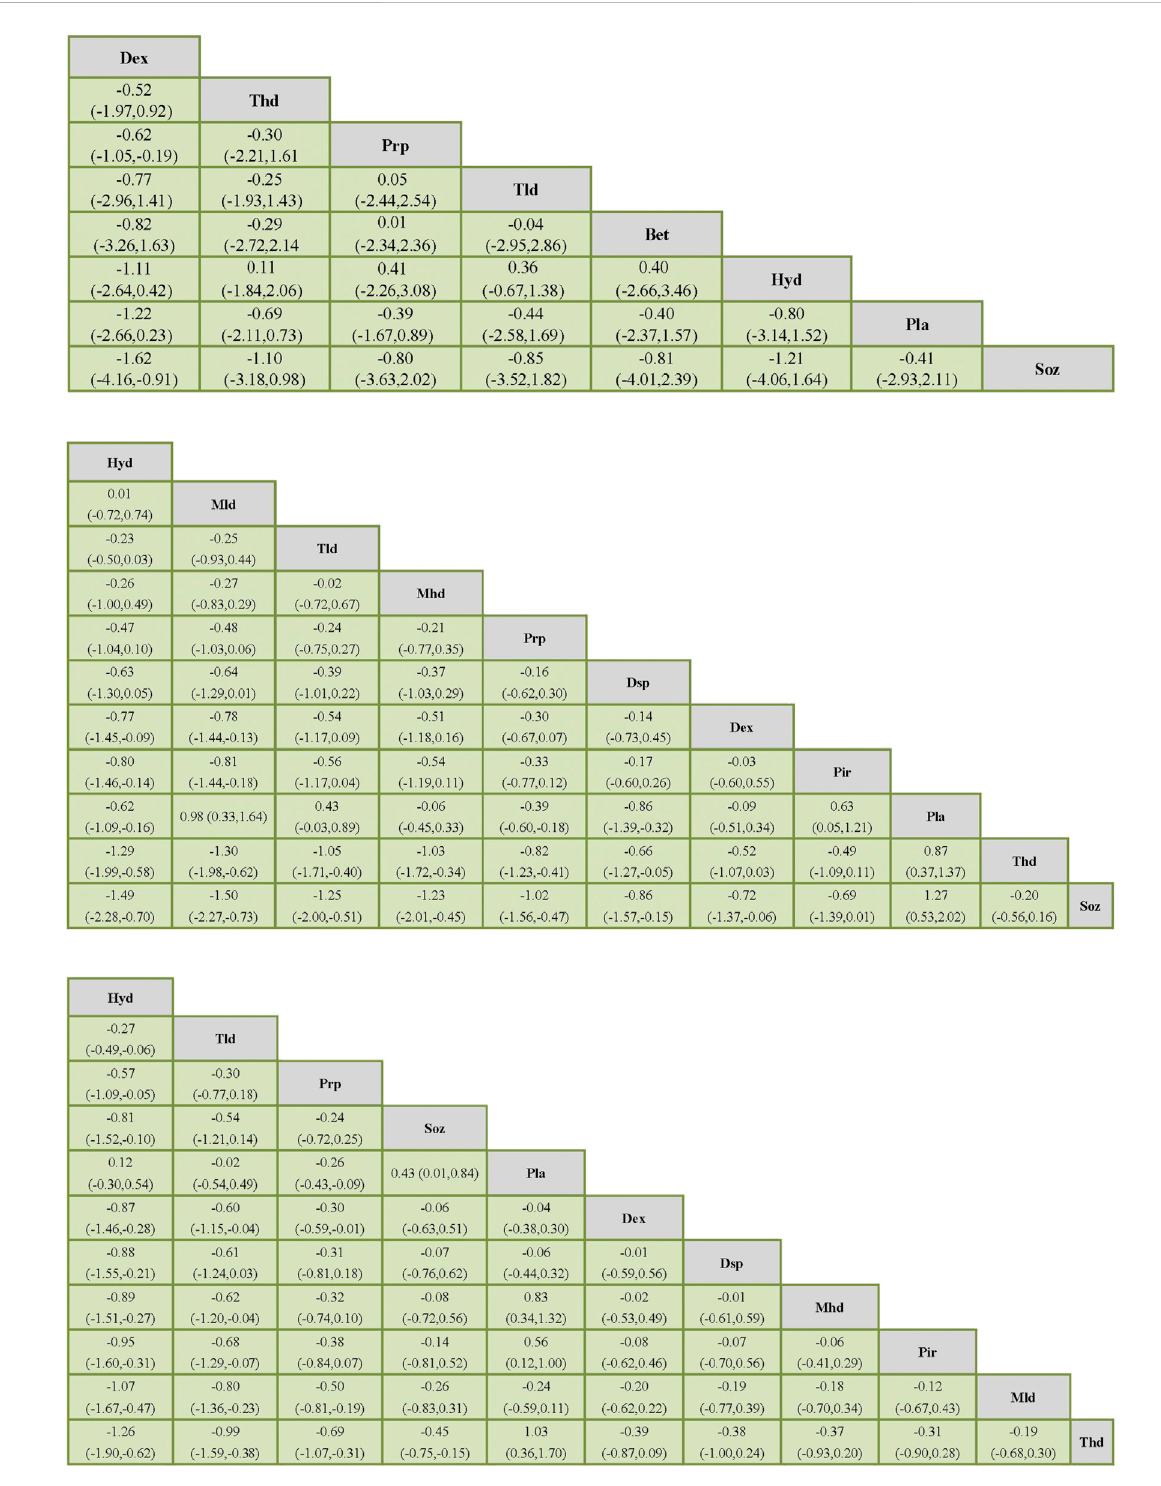
FIGURE 5 Network meta-analysis of outcomes (VAS). Network meta-analysis of outcomes (SSS). Network meta-analysis of outcomes